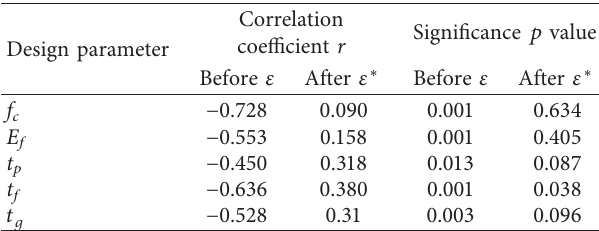
Table 12: Check for the randomness of the model uncertainty factor (AM